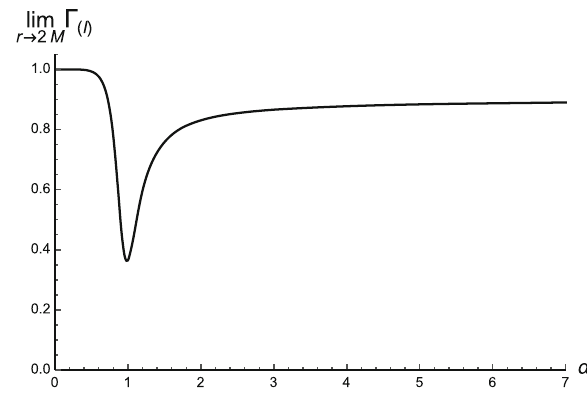
Fig. 1 Plot of lim r → 2 M Γ (I) as a function of the decoupling parameter α